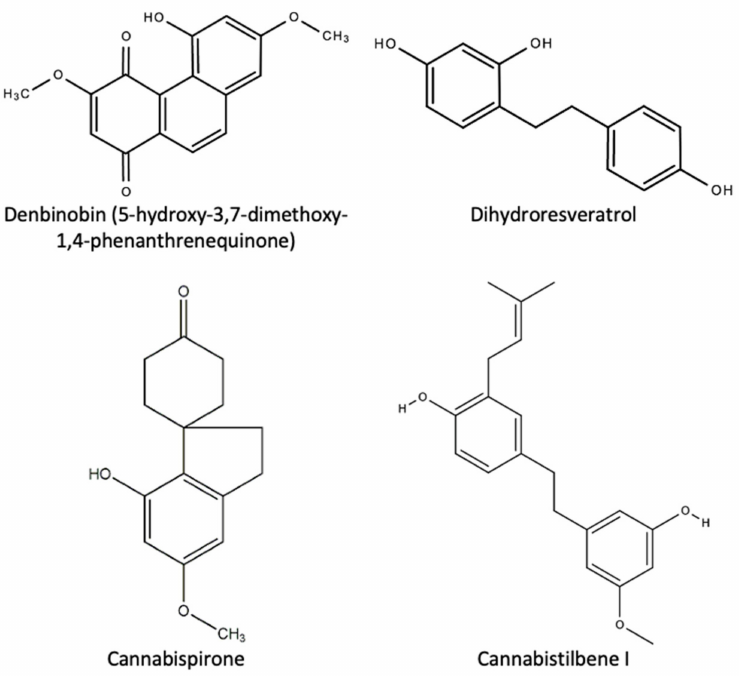
Figure 11. The chemical structures of some stilbenes and their derivates found in C. sativa